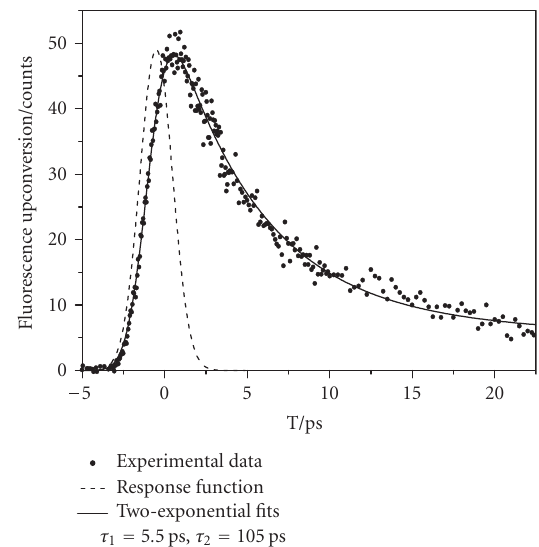
Figure 7: Initial fluorescence decay in C8O3 aggregates as detected by fluorescence upconversion (dots). Solid line: two-exponential fit with time constants 5.5 and 105 picoseconds. The response function is given by the dashed line.